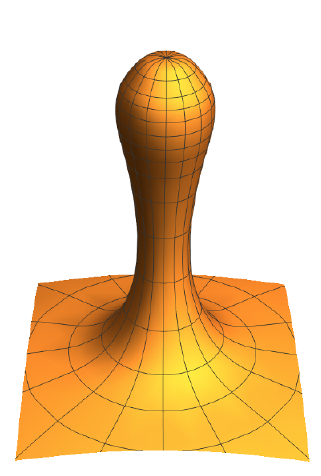
Figure 1 . Embedding in three-dimensional hyperbolic space of a \black globule", i.e., a protrusion on the hyperbolic black hole horizon resembling a spherical mass suspended over the black hole